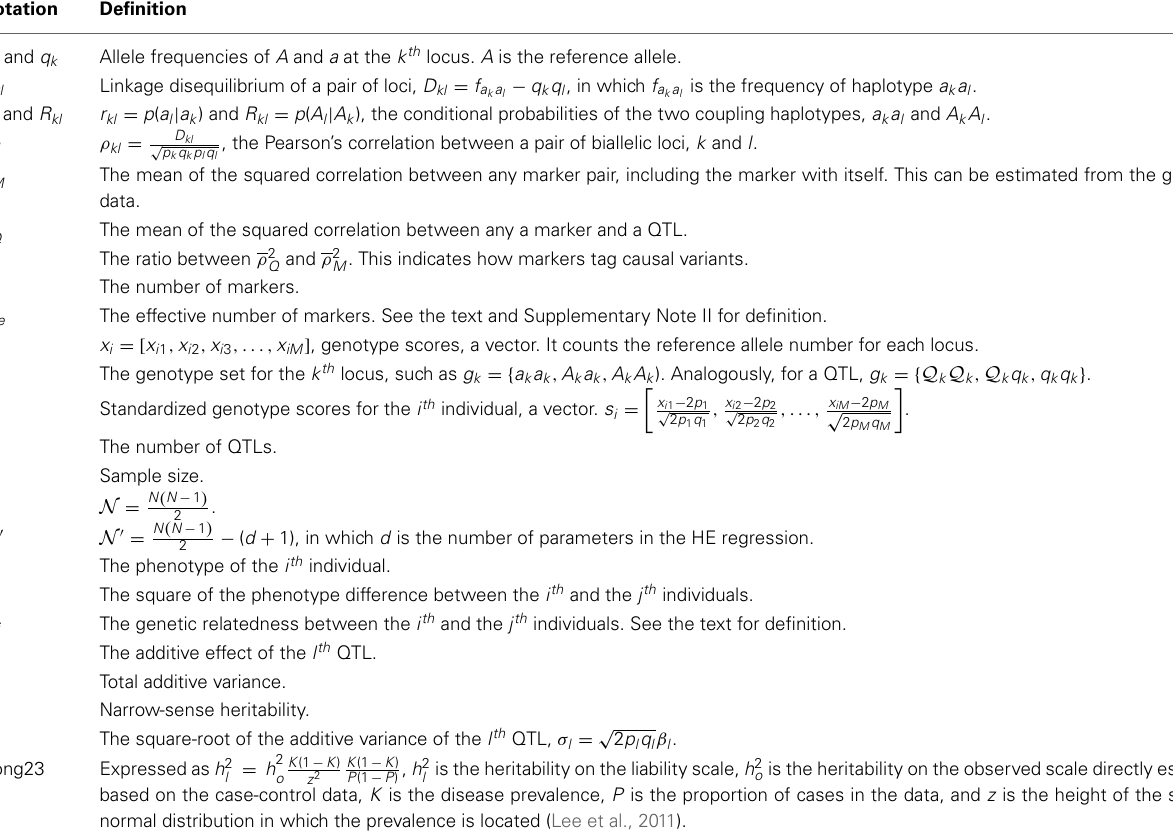
Table 1 | Notation